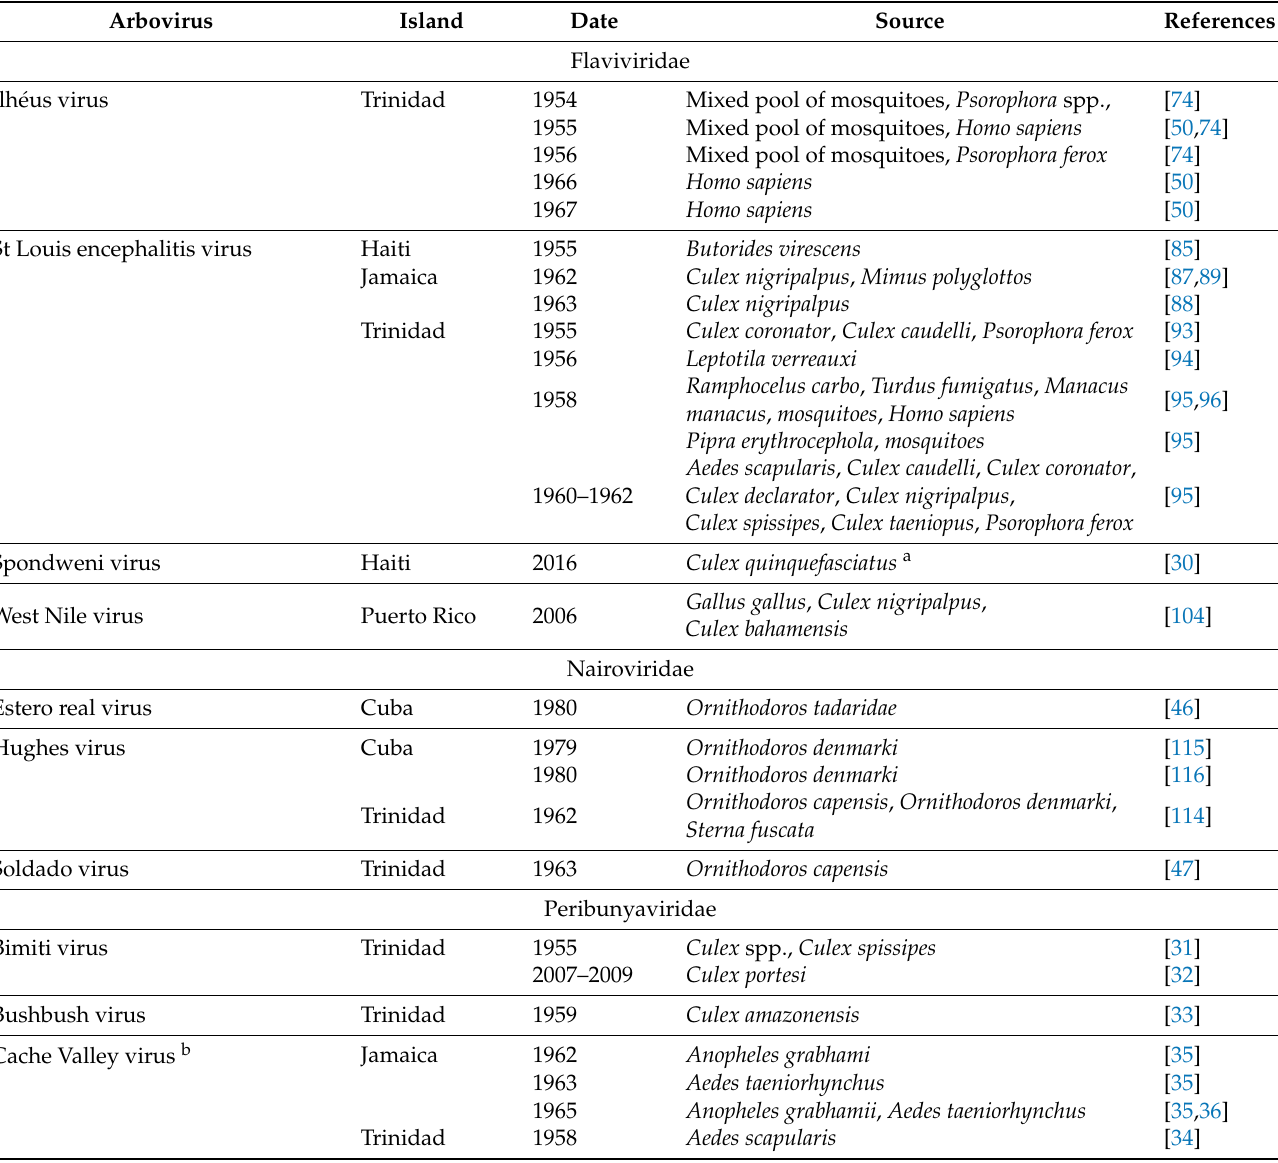
Table 1. Isolation of arboviruses or detection of nucleic acids in the islands of the insular Caribbean.